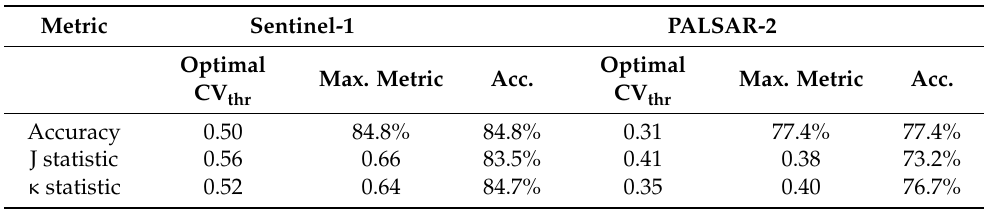
Table 5. Optimal CV thr values as function of performance metric (rows) and observing platform (columns). Values in parentheses show the metric’s maximum value.